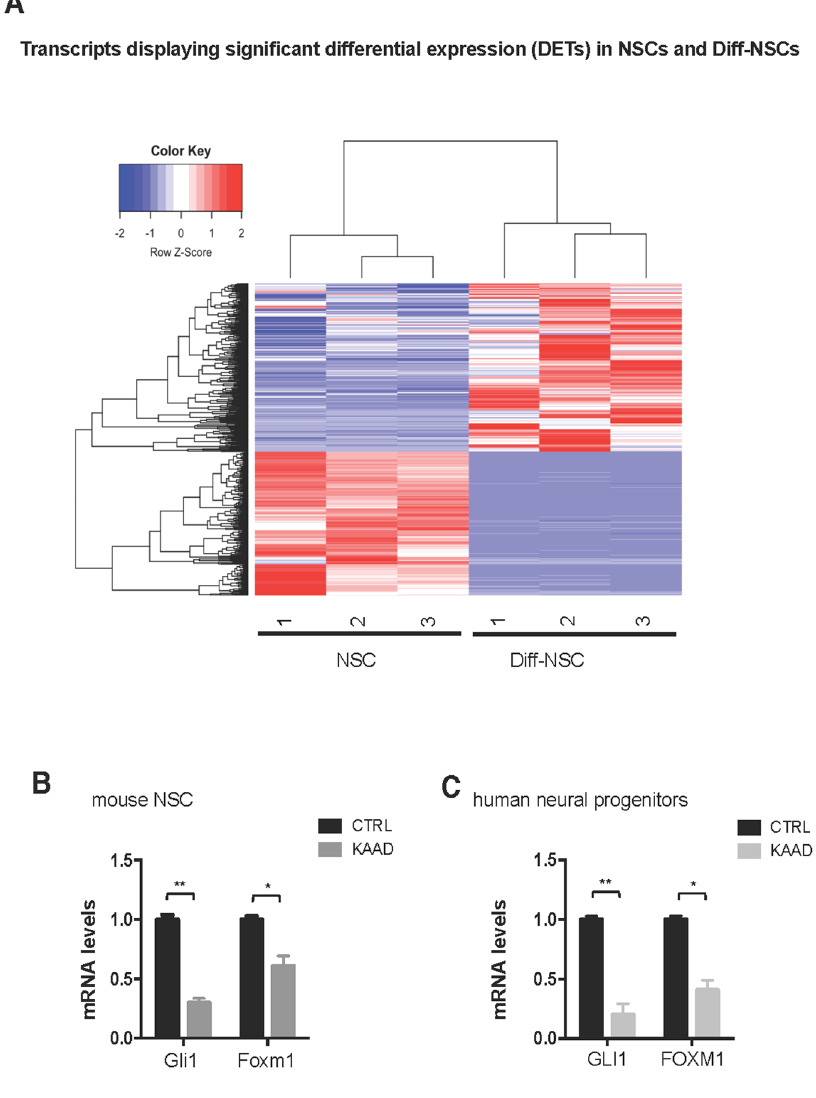
Figure 1. Foxm1 levels upon modulation of the Hedgehog pathway. ( A ) Hierarchical clustering of the 988 transcripts differentially expressed (adj. P < 0.05) (Bray-Curtis method with average linkage). ( B ) RT-qPCR data showing Gli1 and Foxm1 levels in mouse NSCs before and after 48 h of cyclopamine-KAAD (KAAD) treatment. P values vs. CTRL (DMSO as control) ( * P < 0.05: 0.0412, ** P < 0.01: 0.0044). (Mann–Whitney U test). ( C) RT-qPCR data showing GLI1 and FOXM1 levels in normal human neural progenitors (NHNP) before and after 48 h of cyclopamine-KAAD (KAAD) treatment. P values vs. CTRL (DMSO as control). ( * P < 0.05: 0.02, ** P < 0.01: 0.0031). (Mann–Whitney U test). Bars in B and C represent the mean (SD) of three independent experiments.